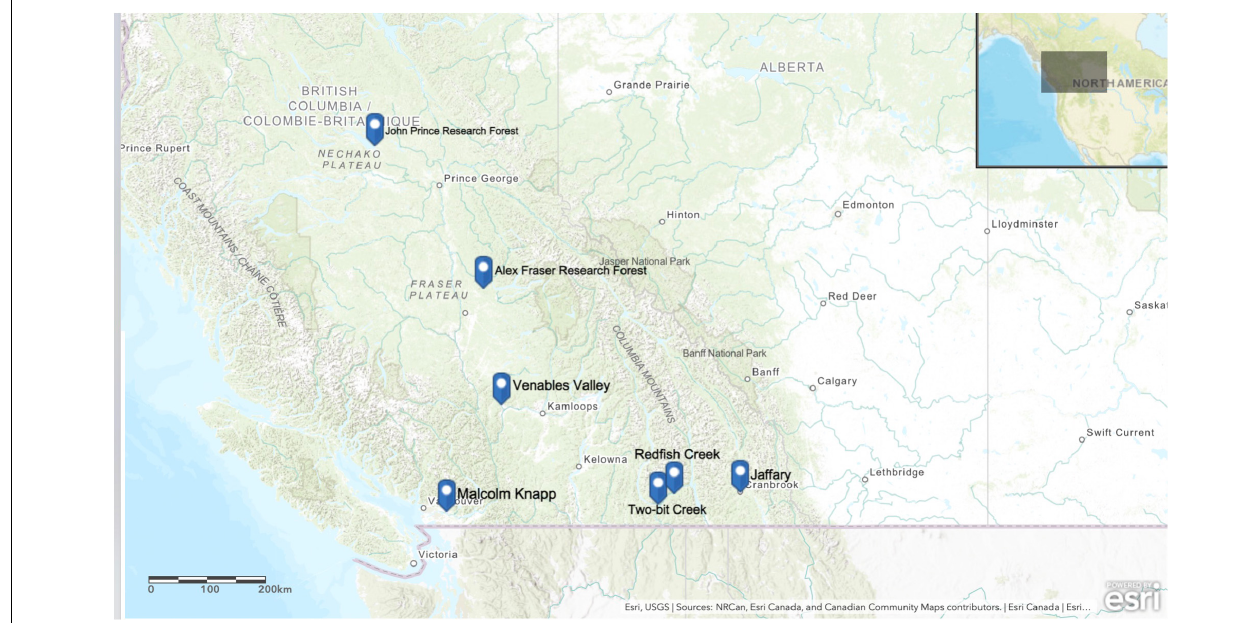
FIGURE 1 | Map of the seven research locations across British Columbia, Canada used in this study.